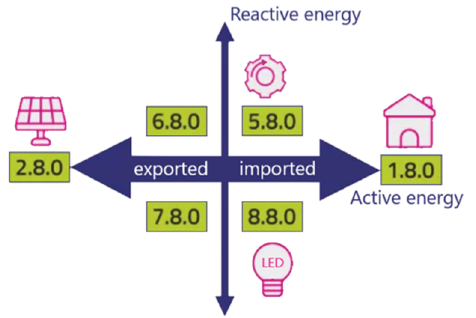
Figure 12. Registers in four quadrants energy meter.